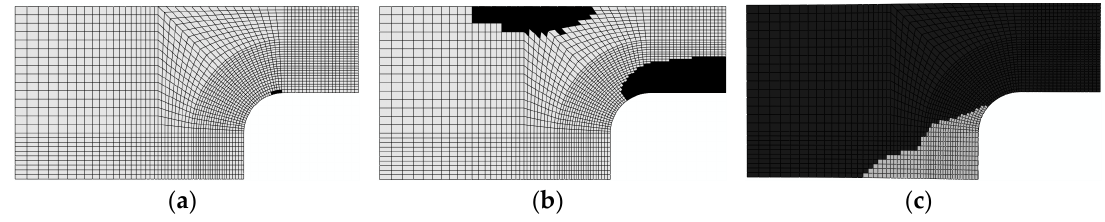
Figure 16. Matrix fragmentation damage of repaired fiber caused by transverse or shear compression (90°): ( a ) 50 kN; ( b ) 85 kN and ( c ) 213.1 kN.